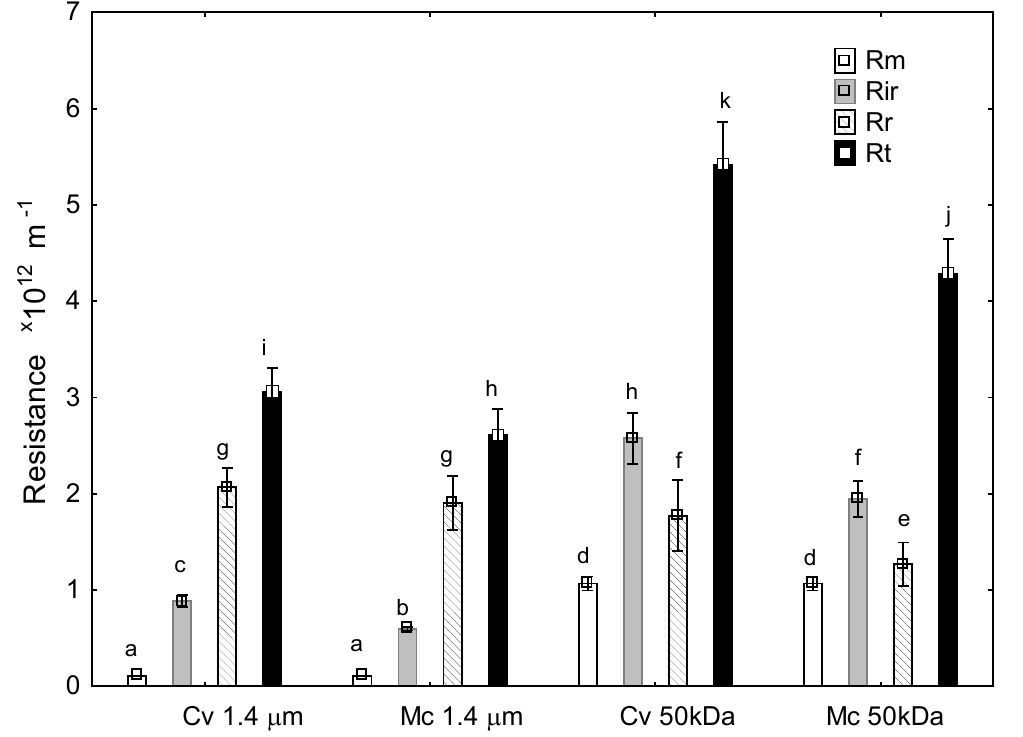
Figure 4. Resistances (R m -membrane resistance; R ir -irreversible resistance; R r -reversible resistance; R t total hydraulic resistance) measured during filtration of microalgal solution (Cv– C. vulgaris ; Mc- M. contortum ) through 1.4 µm and 50 kDa ceramic membranes (mean value; whiskers-mean ± 2 standard error; a-k-different subscripts indicate significant differences, ANOVA, Tukey HSD test, p < 0.05). There was also a variation in the share of each type of resistance in Rt (Figure 5). In filtration through the 1.4 µ m membrane, the share of Rr was dominant, whereas in filtration through a 50 kDa membrane, the role of Rir was dominant. Compared to the 1.4 µ m membrane, the 50 kDa membrane had a higher share of Rm in Rt.